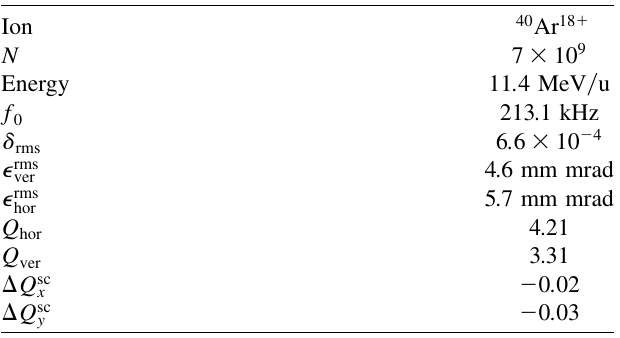
TABLE I. Beam and machine parameters during the measure- ment. The space charge tune shifts are evaluated from the measured